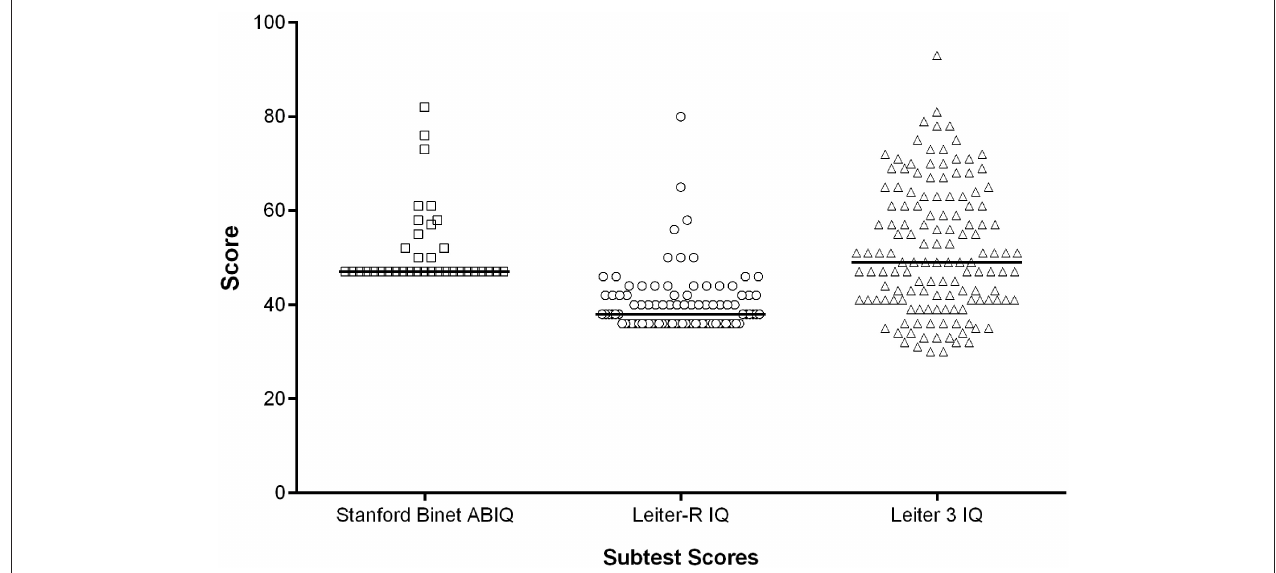
FIGURE 2 | IQ scores: distributions using three different IQ scales. The horizontal bar represents the median